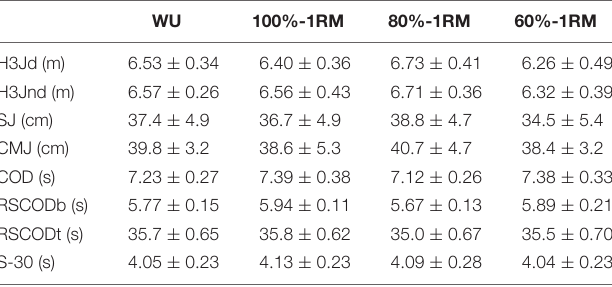
H3Jd and H3Jnd, triple hop test with dominant and non-dominant leg, respectively, SJ, squat jump; CMJ, countermovement jump; COD, change of direction ability test; RSCODb and RSCODt, repeated sprint with change of direction best and total times, respectively, S-30, linear 30-m sprint test. WU, control warm-up protocol; 100%-1RM, 80%-1RM, and 60%-1RM, PAP warm-up protocols at 60, 80, and 100% of one repetition maximum in